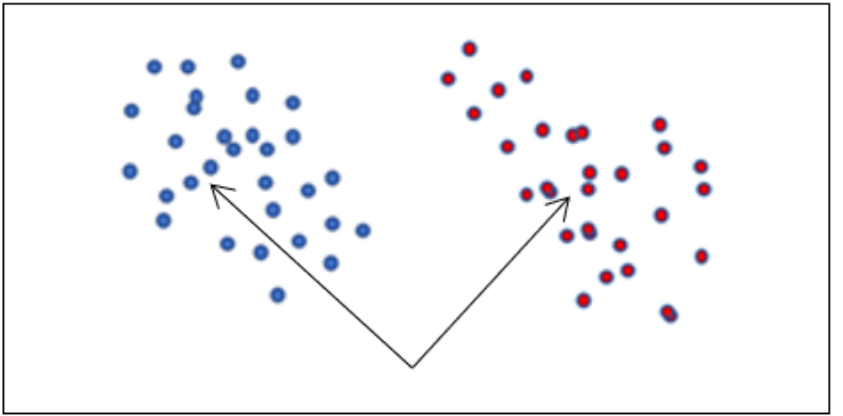
Figure 1. CCA algorithm classification.